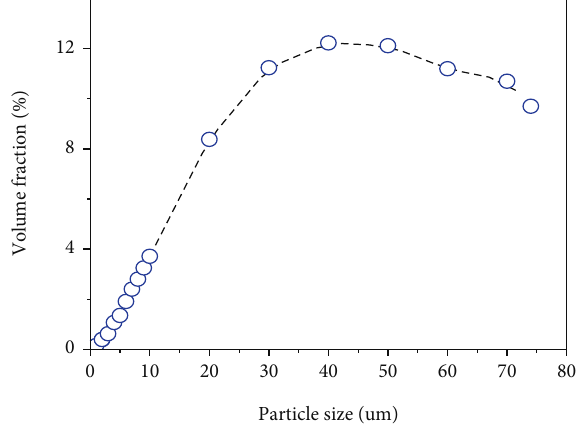
Figure 21: Tailing sand particles pass through steel mesh compared with third